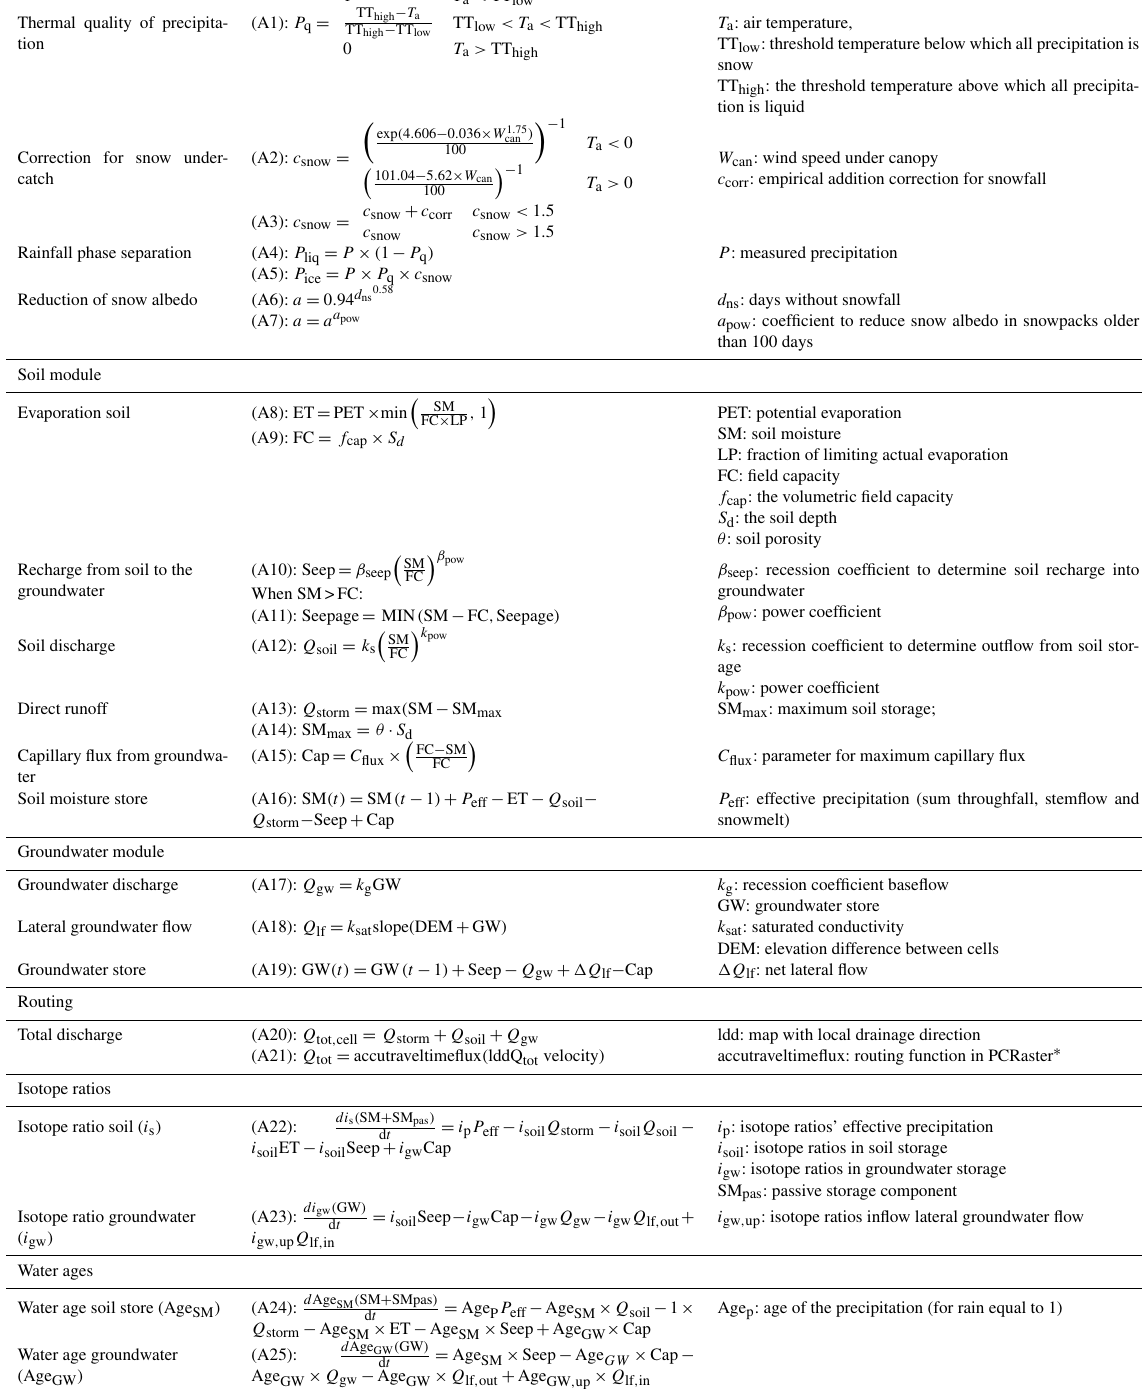
Table A1. Snow module (for parameters in the model calibration, full description in Ala-aho et al., 2017b).